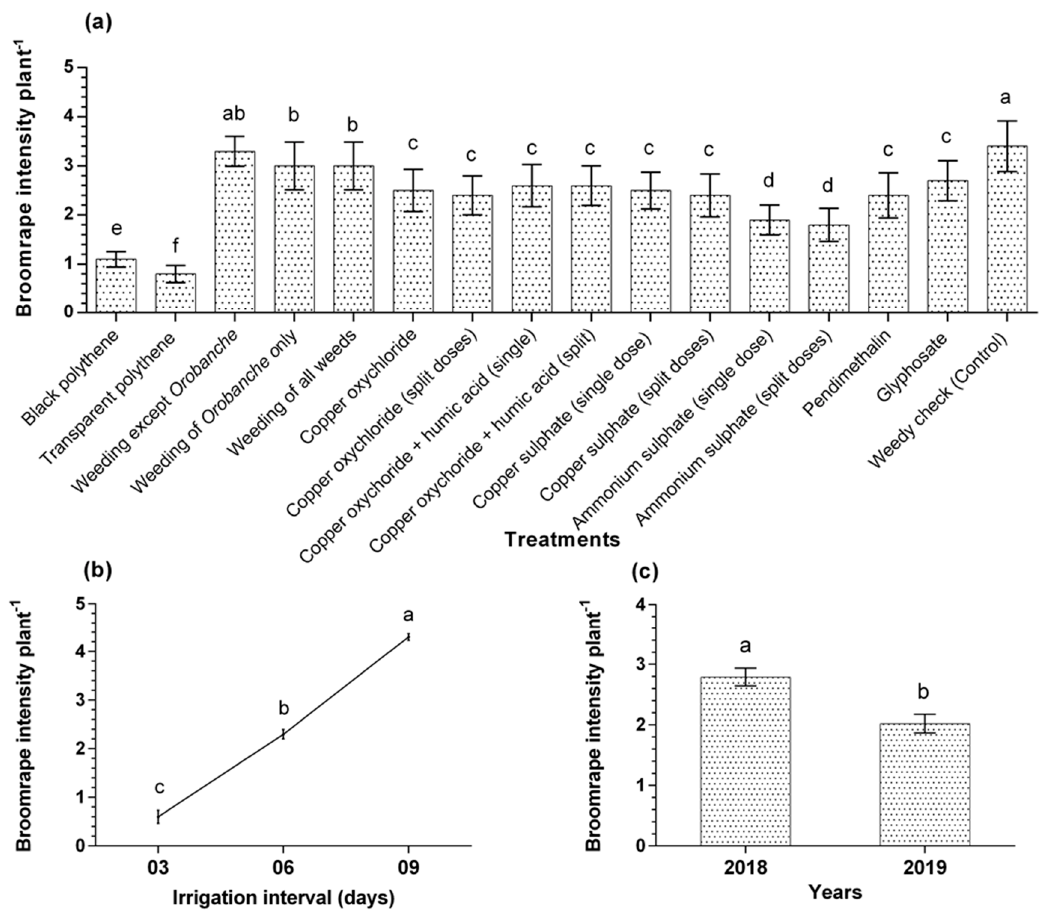
Figure 5. Response of broomrape intensity of attack plant − 1 of tomato to various irrigation intervals and weed management treatments. ( a ) Effect of various treatments on broomrape intensity of attack. ( b ) Effect of Irrigation intervals on broomrape intensity of the attack. ( c ) Influence of years on broomrape intensity of the attack. Based on the Least significant difference test, line and column ± standard error followed by different alphabetical letters are significantly different from each other at a 5% level of probability .